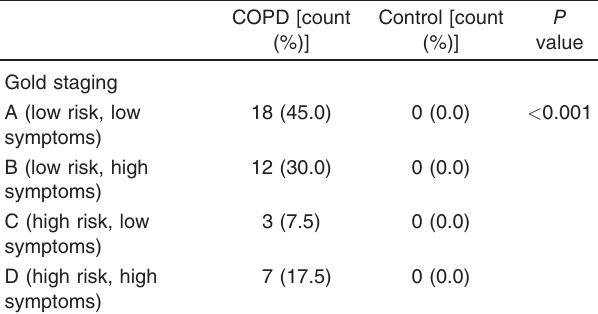
Table 3 Classification of chronic obstructive pulmonary disease patients according to Global Initiative for Chronic Obstructive Lung Disease staging